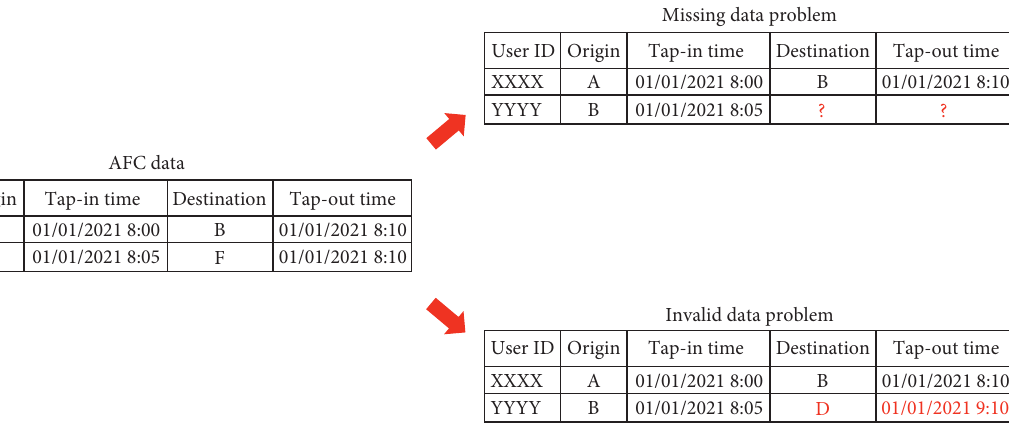
Figure 1: Missing and invalid data problems in the AFC